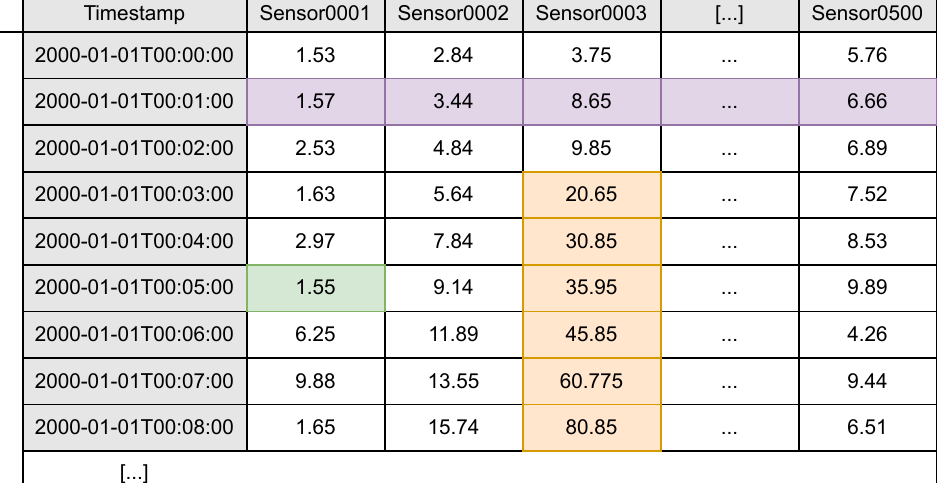
Figure 6. Table-like representation of a sample set of sensor readings consisting of 500 sensors that deliver data each minute. The green color highlights a sample triplet of value 1.55, the purple color highlights a sample row starting with a triplet of value 1.57, and the orange color highlights a sample column starting with a triplet of value